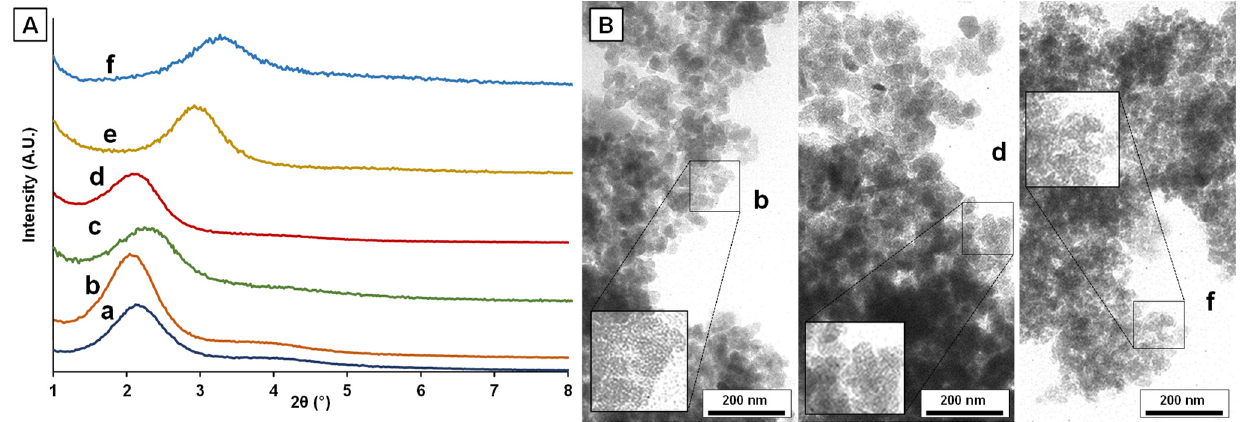
Figure 1. ( A ) Low-angle XRD patterns and ( B ) selected TEM images of the synthesized materials: (a) Fe100-UVM-7-C 16 , (b) Fe50-UVM-7-C 16 , (c) Fe25-UVM-7-C 16 , (d) Fe10-UVM-7-C 16 , (e) Fe50-UVM- 7-C 12 , and (f) Fe50-UVM-7-C 10 . The images shown in the insets correspond to ×2 magnification.